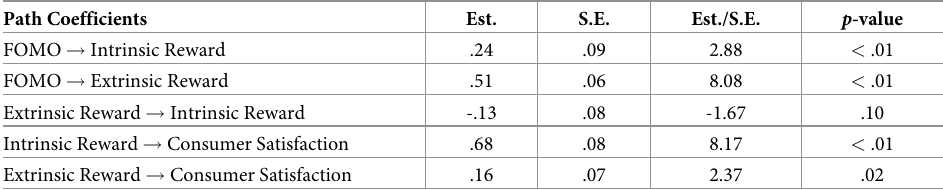
Table 5. Study 2: Path coefficients of the Structural